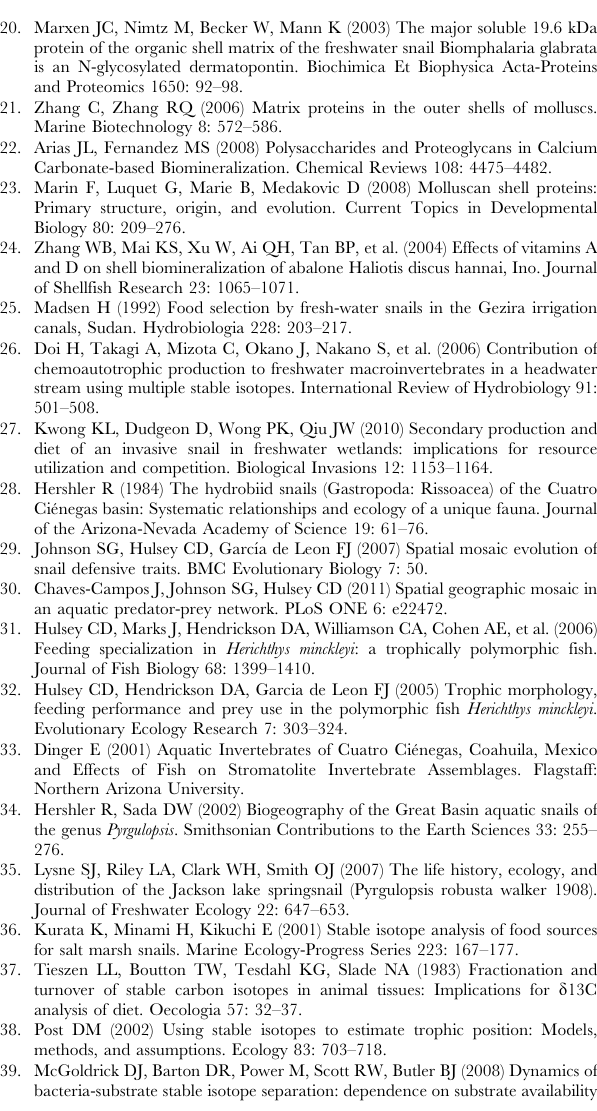
and phosphorus (P) concentration, total fish density (papilliforms + molariforms), water lily abundance, and snail density. D AIC is the difference between the AIC values of a given model and the model with the lowest AIC value. Models with statistical support (i.e. D AIC # 6) are shown in